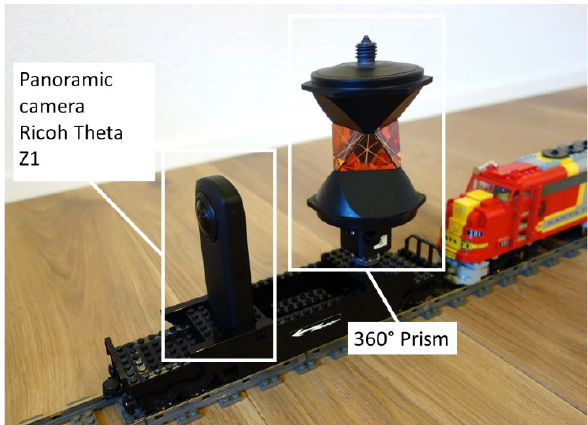
Figure 1. Mobile sensor platform with panoramic camera Ricoh Theta Z1 and 360° prism mounted on a LEGO model train Another criterion for distinguishing image-based orientation estimation is the estimated degrees of freedom (DoF). Visual compass methods limit themselves to a single axis (yaw). In the Visual Compass approach of Morbidi and Caron (2017), only the horizontal direction change is determined from the phase correlation of two consecutive images. Visual gyroscopes estimate the attitude (roll, pitch and yaw angles). The two approaches of Hartmann et al. (2015) are either real-time capable but too inaccurate or not real-time capable. Caron and Morbidi (2018) extended their Visual Compass approach